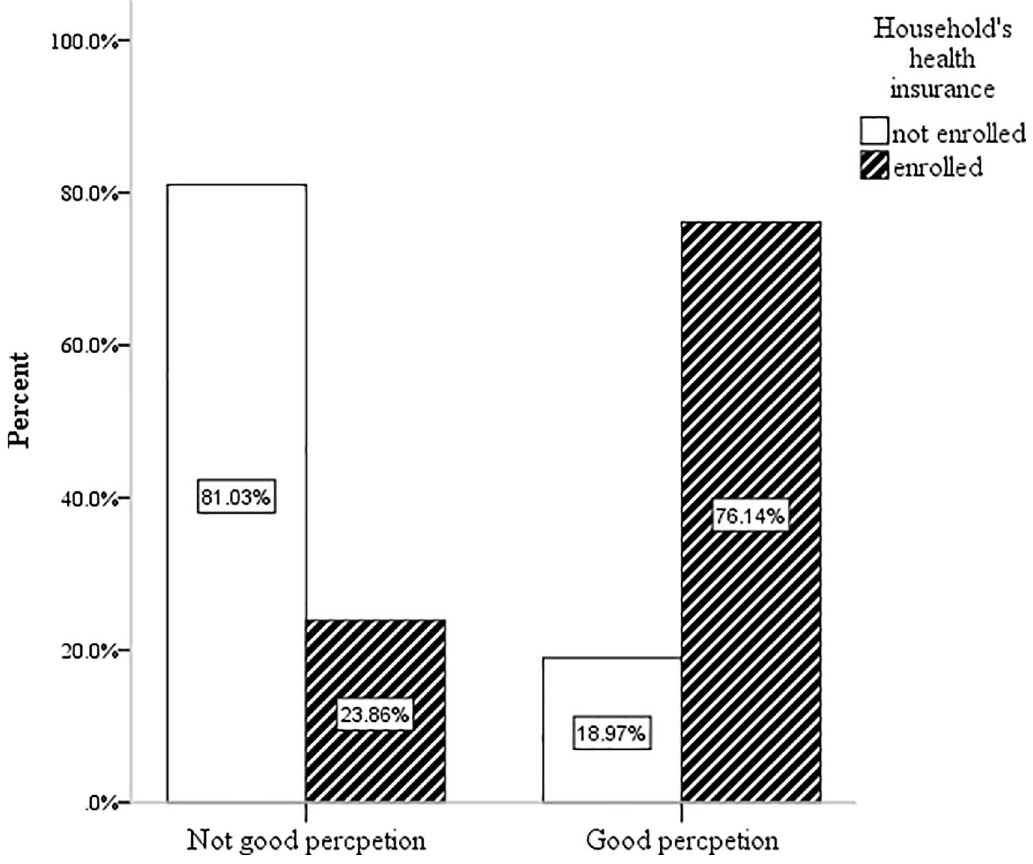
Fig 1. Ranking of perception of participants towards enrolment of CBHI in Tach-Armachiho district, North Gondar, 2019.